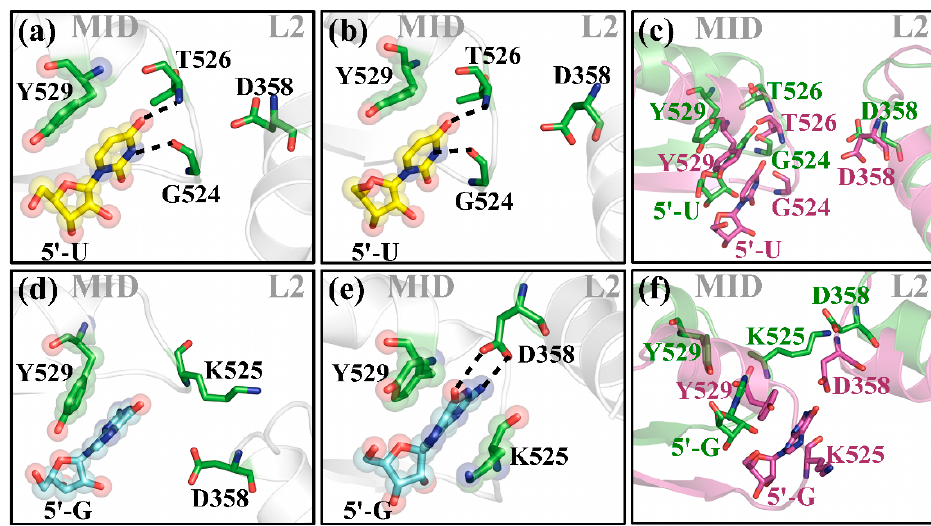
Figure 6. Close-up of the guide RNA 5'-end and relevant protein residues of the MID domain and L2 linker region. The MID domain and the L2 helix are represented in cartoon (grey); important protein residues (green); and 5 ′ -U (yellow); or 5 ′ -G (blue) are shown in sticks. For clarity, merely the terminal base is shown. Hydrogen bonds are represented by black dotted lines. Transparent spheres highlight stacking interactions between protein residues and the corresponding bases. ( a , d ) show the initial situation; and ( b , e ) after 20 ns of simulation of 5 ′ -U and 5 ′ -G terminated hAgo2 bound guide strands, respectively; ( c , f ) superposition of ( a , b ); and ( d , e ) with neighboring protein residues at t = 0 ns are shown in green and at t = 20 ns in magenta.